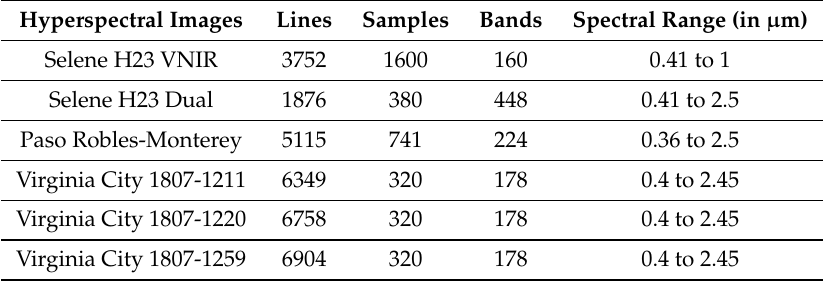
Table 1. The dimensions of the hyperspectral scenes used in this paper. Hyperspectral Images Lines Samples